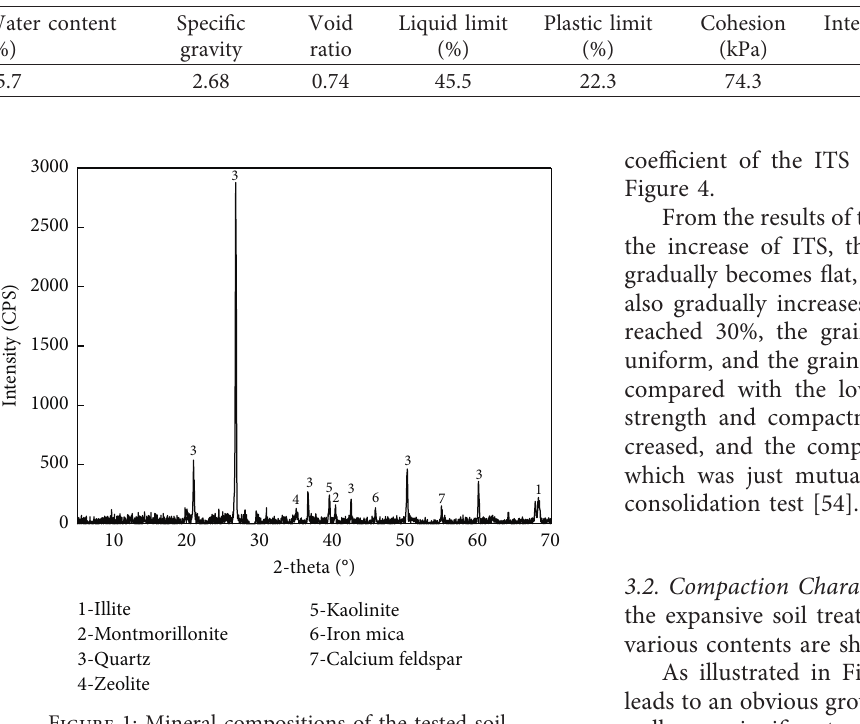
Table 1: Basic physical properties of expansive soil.